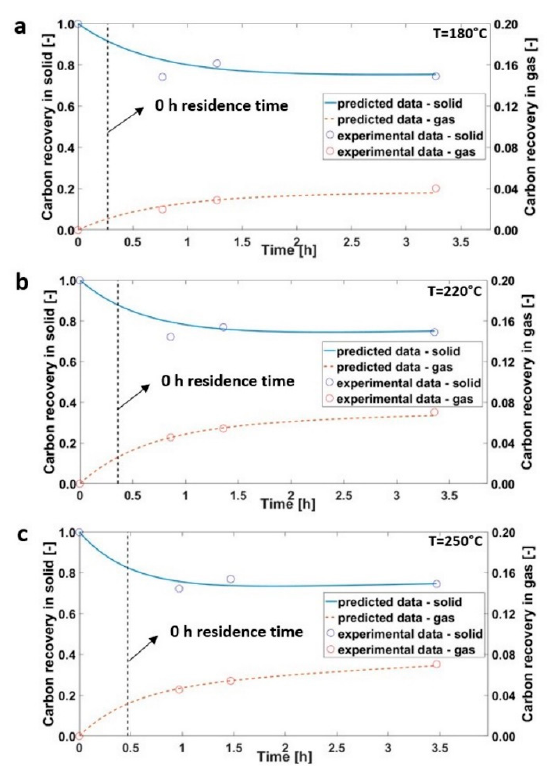
Figure A2. Carbon recovery in solid and gas phases for Opuntia ficus indica : ( a ) 180 °C, ( b ) 220 °C, and ( c ) 250 °C. Table A1. Percentage differences between model predictions and experimental data, calculated by means of Equation (18) for carbon recovery in solid phase for olive trimmings, grape marc, and Opuntia ficus indica. Error (%) Process Conditions Olive Trimmings Grape Marc Opuntia Ficus